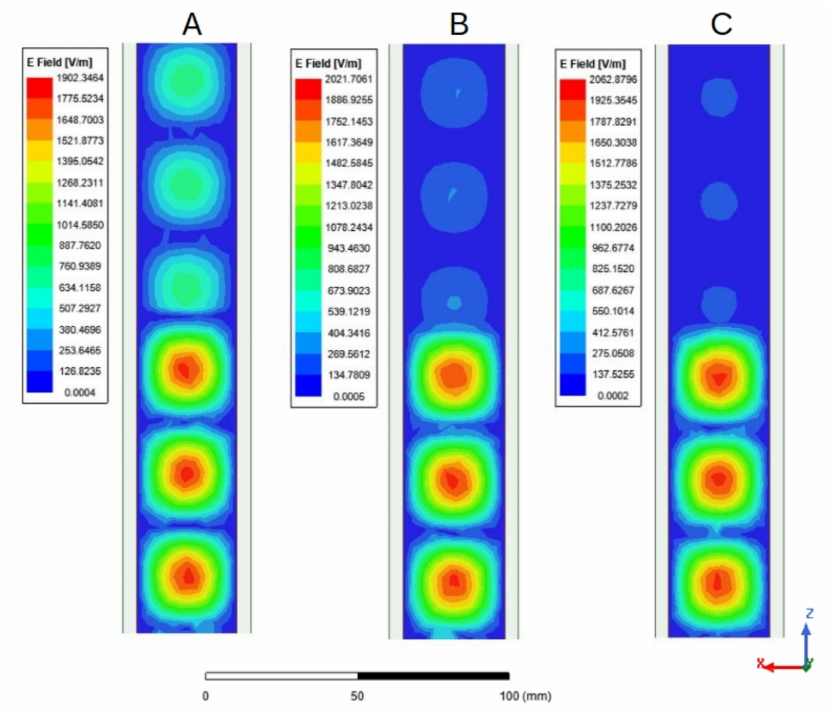
Figure 11. Electric field intensity distribution (ANSYS HFSS) in the WR-137 waveguide fragment, in TE10 mode for 6 GHz, in front of and behind a PAN fabric barrier covered with 1 PANI layer ( A ), 3 PANI layers ( B ) and 5 PANI layers ( C ).